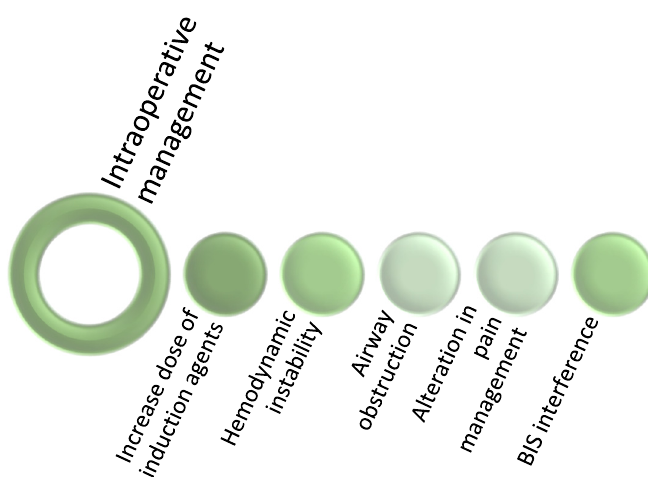
Figure 3. Intraoperative management of the individual with cannabinoid intake .